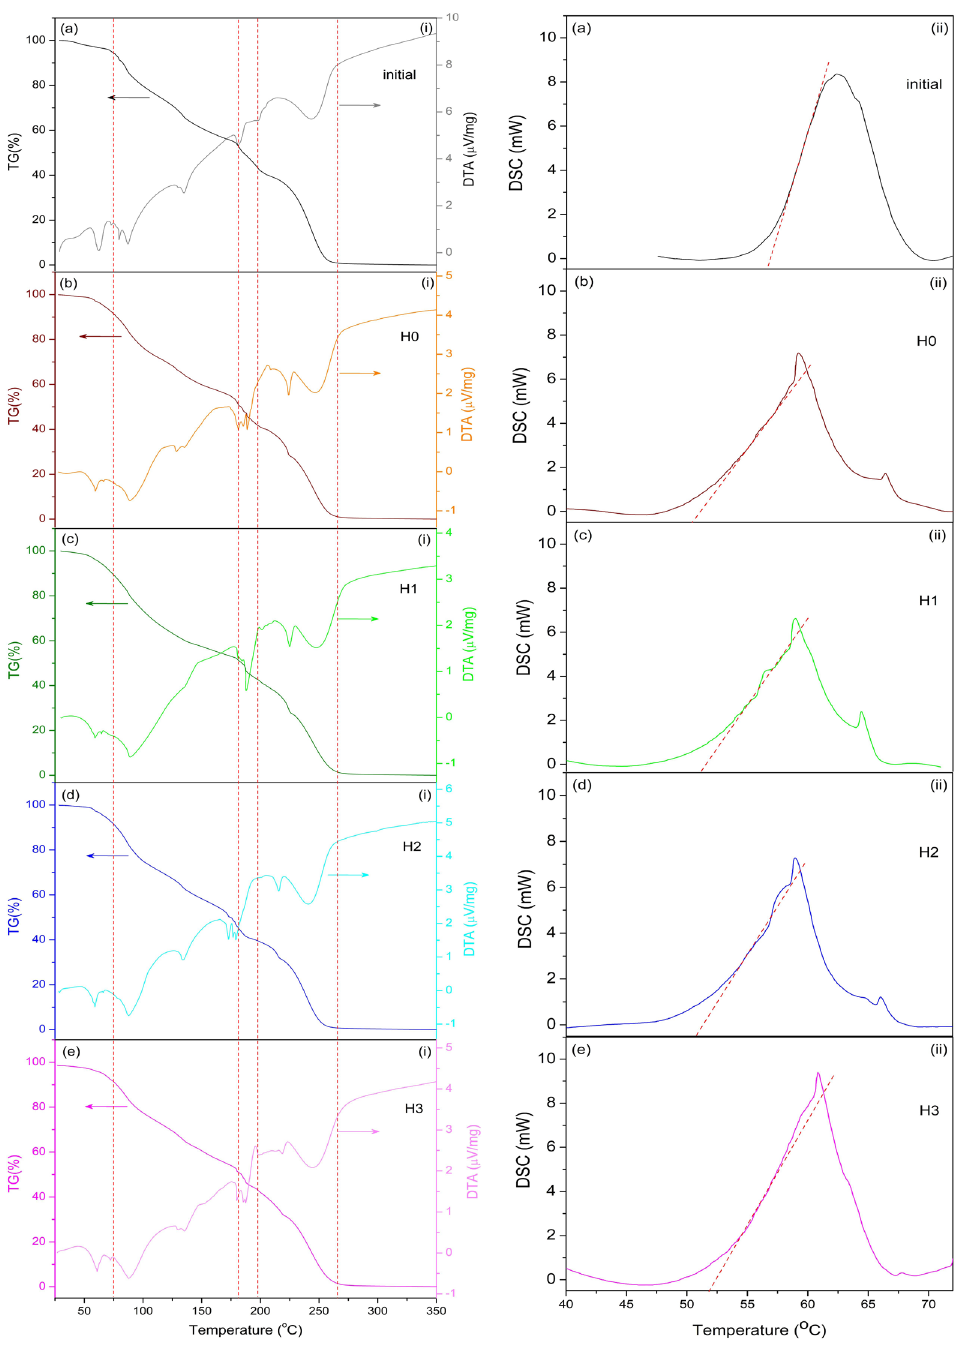
Figure 5. Left: TGA/DTA curves, and right: DSC thermogram, of (a) initial sample of CoNHH, and (b)-(e) CoNHH after thawing-freezing in different magnetic fields of: